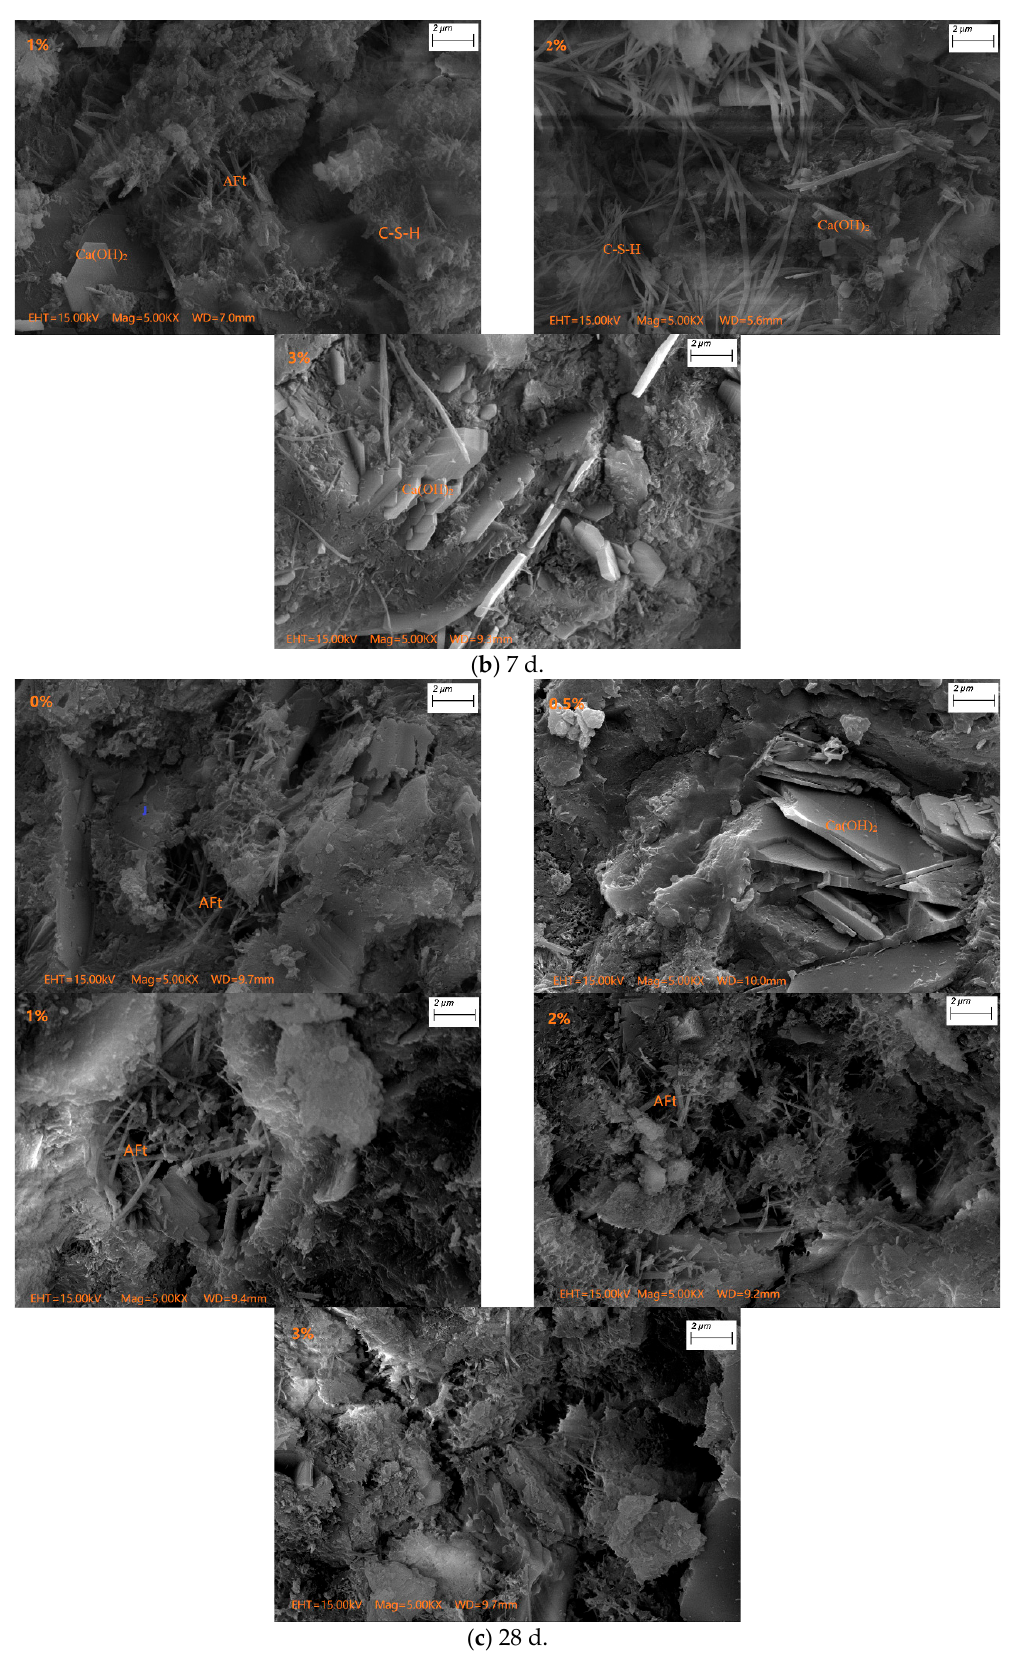
Figure 9. SEM images of cement pastes with di ff erent contents of nano C-S-H particles at the age of 1, 7, and 28